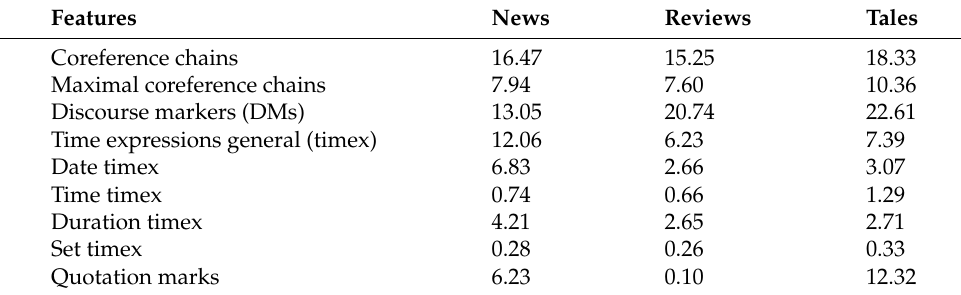
Table 5. Average discourse features per